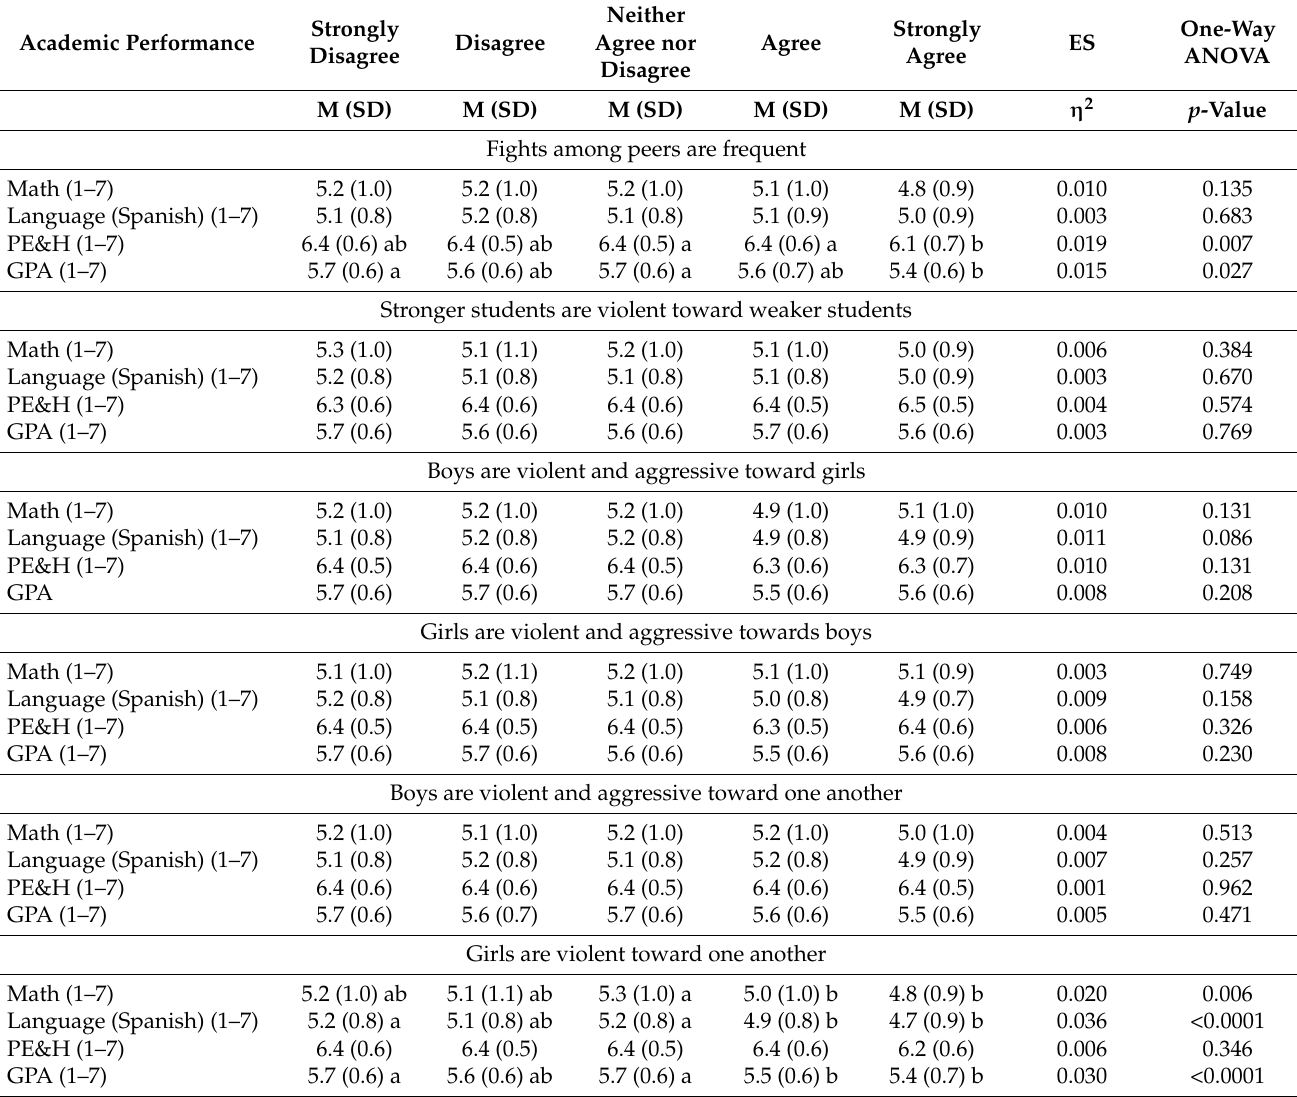
Table 4. AFG and GPA according to the perception of violence and aggressiveness among peers from a gender